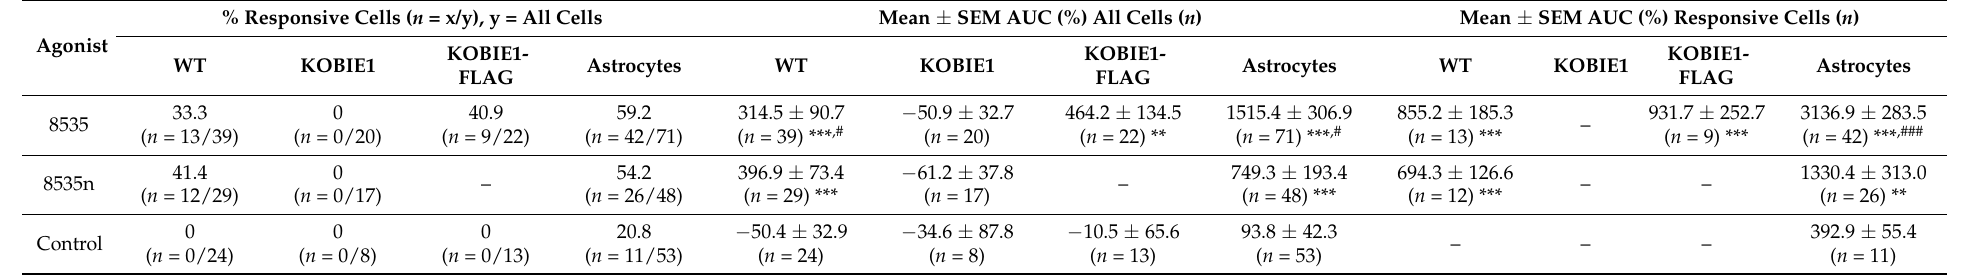
Table 1. Responsiveness and integrated area under the curve (AUC) changes in FRET ratio signal upon exposure to stimuli in different experimental